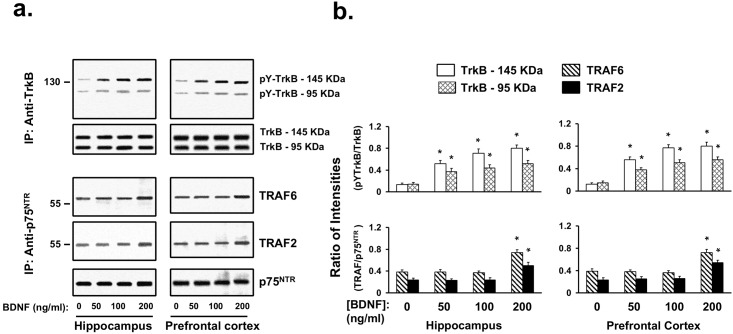
The concentration-response relationships of BDNF-induced TrkB and p75NTR activation.Concentration-response relationships of BDNF-induced TrkB and p75NTR activation indicate that p75NTR is far less sensitive to BDNF than TrkB. (a) The magnitudes of TrkB and p75NTR activation induced by a 30-min incubation with 50–200 ng/ml BDNF were assessed in hippocampal and PFCX slices prepared from naïve P21 rats using pY TrkB and TRAF2/6 recruitment to p75NTR, respectively, as the guides. (b) Densitometric quantification of pY 145- and 95-KDa TrkB and TRAF2/6 blots revealed that while TrkB was activated by 50–200 ng/ml of BDNF in a dose-dependent manner, p75NTR is activated only by 200 ng/ml of BDNF in both hippocampus and PFCX. n = 4. Data are mean ± s.e.m. of the ratios of pY to total 145-, 95-KDa TrkB or TRAF2 and TRAF6 to p75NTR optical intensities. *p < 0.01 compared to the basal level of respective protein.